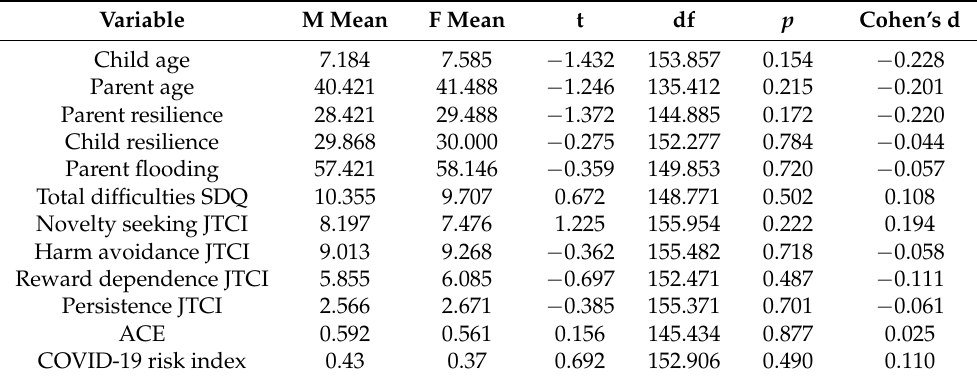
Table 2. Correlations among the study variables.